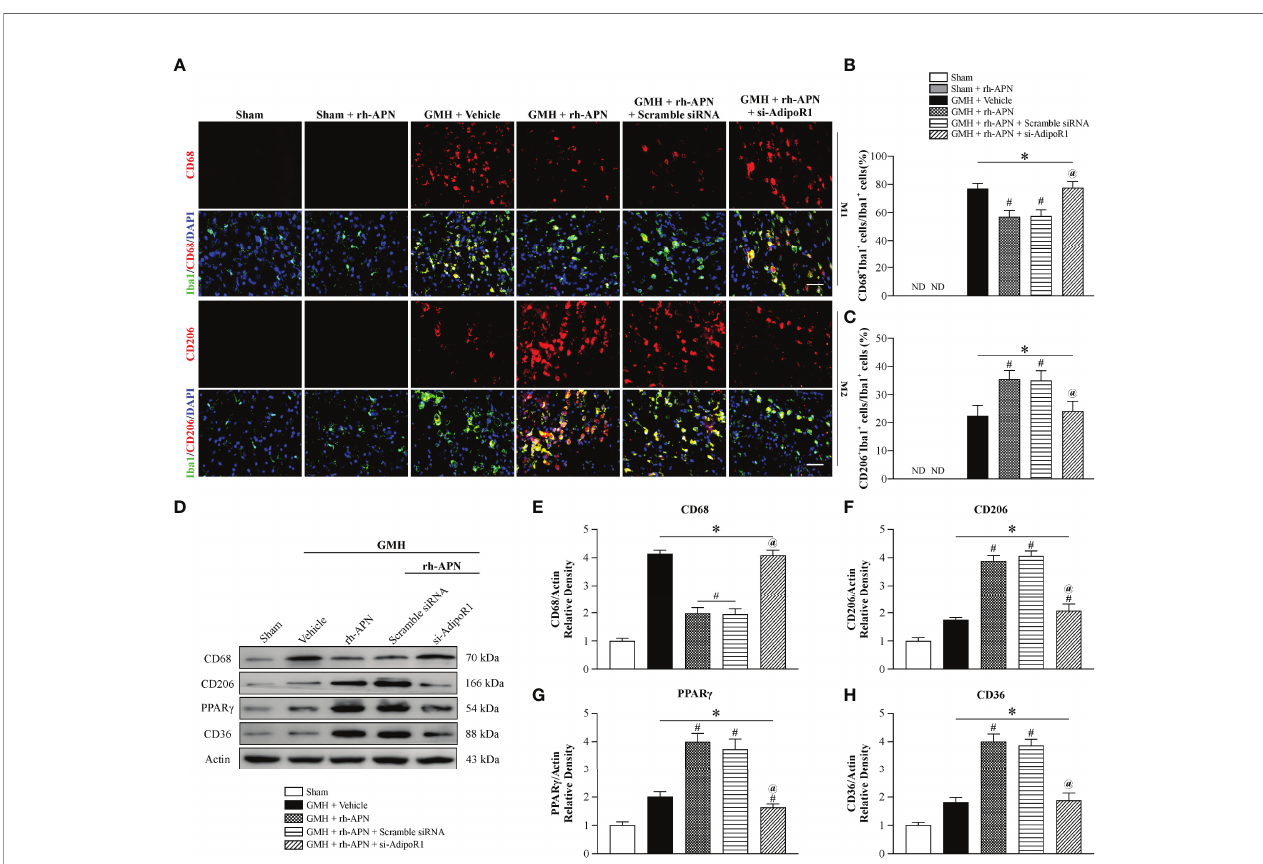
FIGURE 4 | rh-APN treatment promoted M2 microglia polarization at 72 h post GMH. (A) Representative images of immuno fl uorescence staining and quanti fi cation (B, C) depicting co-localization of CD68 (M1 marker, red) or CD206 (M2 marker, red) and Iba-1 (green). Scale bar = 50 m m. (D) Representative image of Western blot data showing the expression of CD68, CD206, PPAR g , and CD36. (E-H) Western blot quanti fi cation showed that the expression of CD68 was markedly increased and CD206, PPAR g , and CD36 expression were slightly increased compared to sham after GMH. (D – H) rh-APN signi fi cantly decreased CD68 expression, while increased the expression of CD206, PPAR g , and CD36. (D – H) However, these effects were reversed by knockdown of AdipoR1 with AdipoR1 siRNA. Values are expressed as mean ± SD. ANOVA, Dunnett. n = 6 for each group. * P < 0.05 compared to sham, # P < 0.05 compared to GMH + Vehicle, @ P < 0.05 compared to GMH + rh-APN or GMH + rh-APN + Scramble